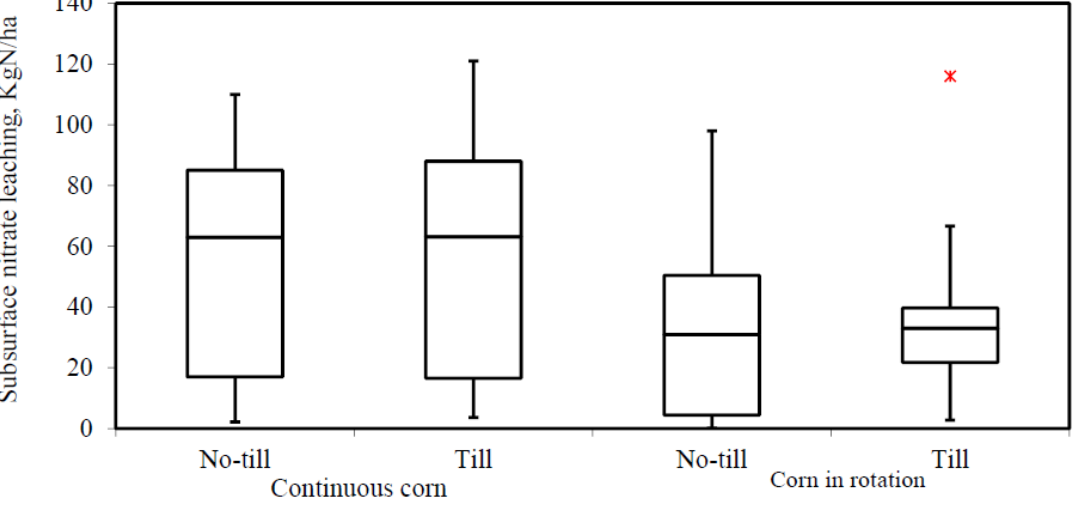
Figure 11. Comparison of tillage effect on nitrate leaching through continuous and corn in rotation (six and eight journal articles were considered for this analysis).